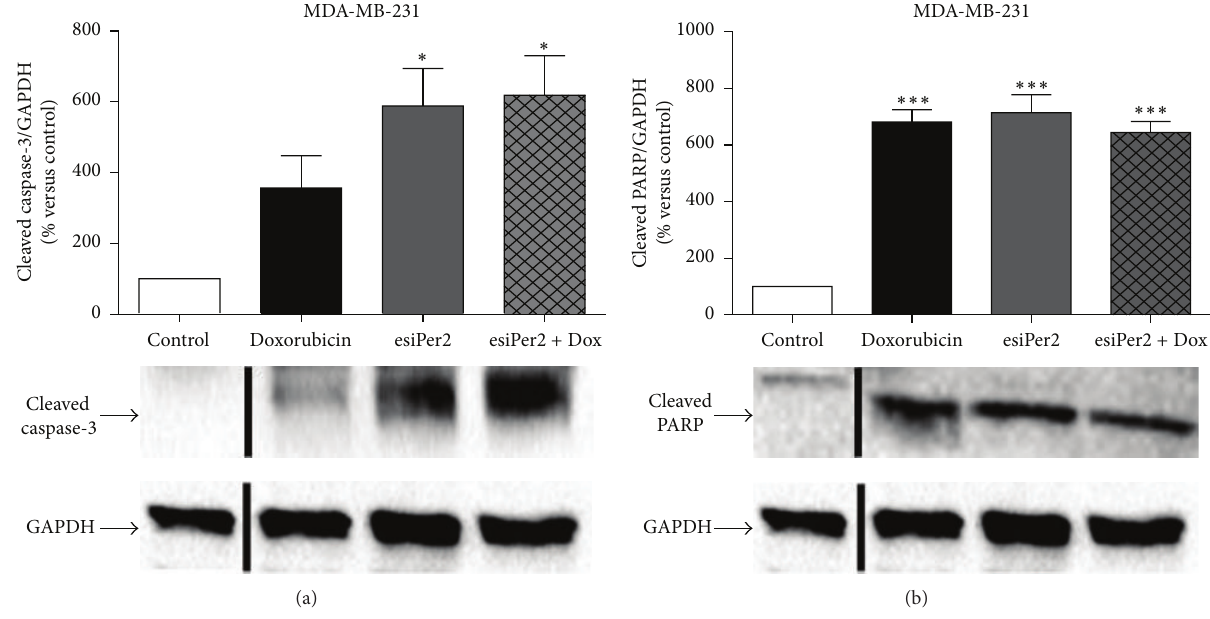
Figure 7: Determining the role of Per2 in caspase-dependent apoptosis. MDA-MB-231 cells were subjected to (1) control conditions (C), (2) 2.5 𝜇 M doxorubicin (D), (3) 30 nM Per2 esiRNA (P), and (4) 30 nM Per2 for 48 hours + 2.5 𝜇 M Dox for 24 hours (PD). Whole cell lysates were subjected to immunoblotting with appropriate antibodies for cleaved caspase-3 (a) and PARP (b). Statistical analysis: one way ANOVA with Bonferroni post hoc correction. All results are presented as mean ± SEM ( 𝑛 = 3 ). ∗ = 𝑃 < 0.05 versus control and ∗ ∗ ∗ = 𝑃 < 0.0001 versus